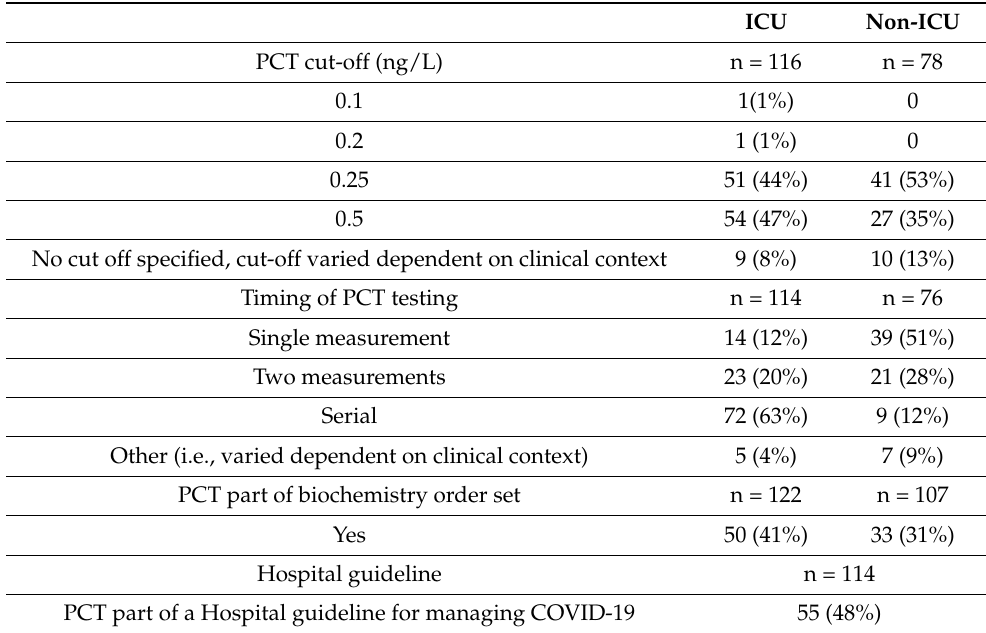
Table 1. Nature of procalcitonin (PCT) use to support antibiotic prescribing during first wave of COVID-19 pandemic in England and